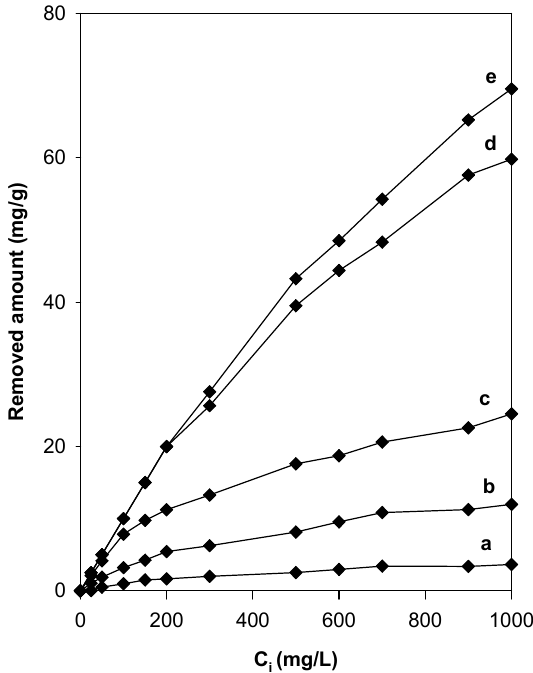
Figure 10. Evolution of the removed amount of eosin with the content of C16TMA + cations in organo-magadiites: ( a ) 0, ( b ) 0.0.17 mmol/g, ( c ) 0.38 mmol/g, ( d ) 0.78 mmol/g, and ( e ) 0.97 mmol/g.